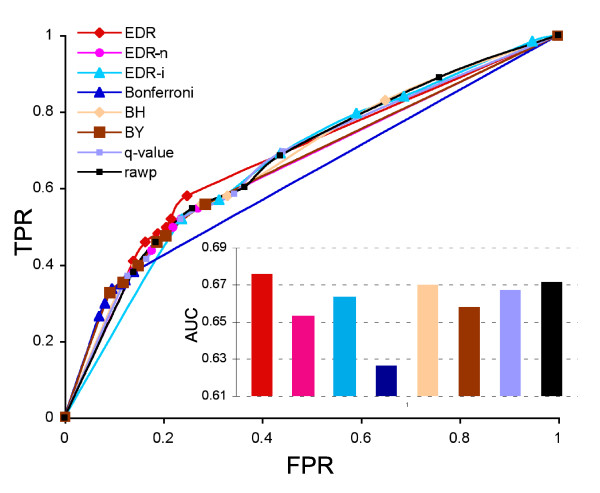
Receiver operator characteristic (ROC) curve. The true positive rate (TPR) and false positive rate (FPR) in differentially expressed genes (DEGs) detected by EDR [equation (5)], EDR-n [equation (3)], EDR-i [equation (2)], or other methods were plotted as ROC curves. The microarray data set [26] tested was confirmed by sequence digital expression.